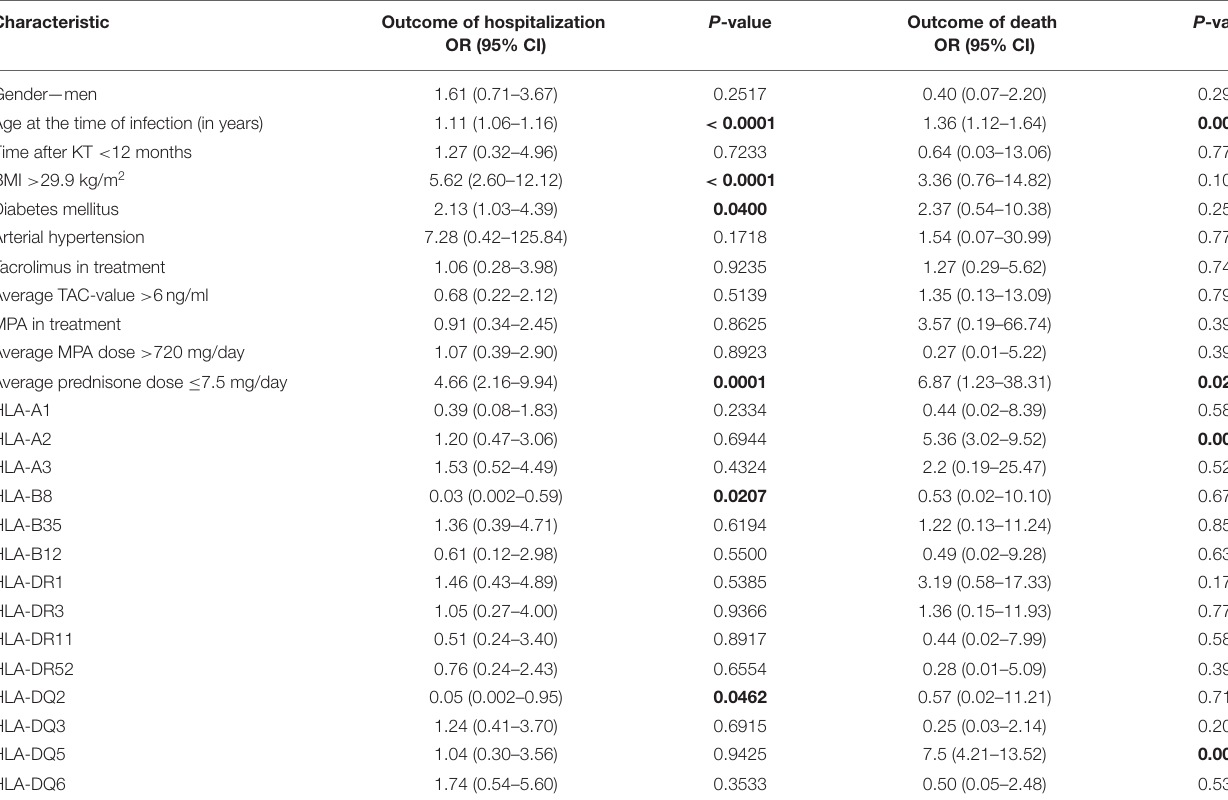
TABLE 3 | Univariable analysis (log regression).